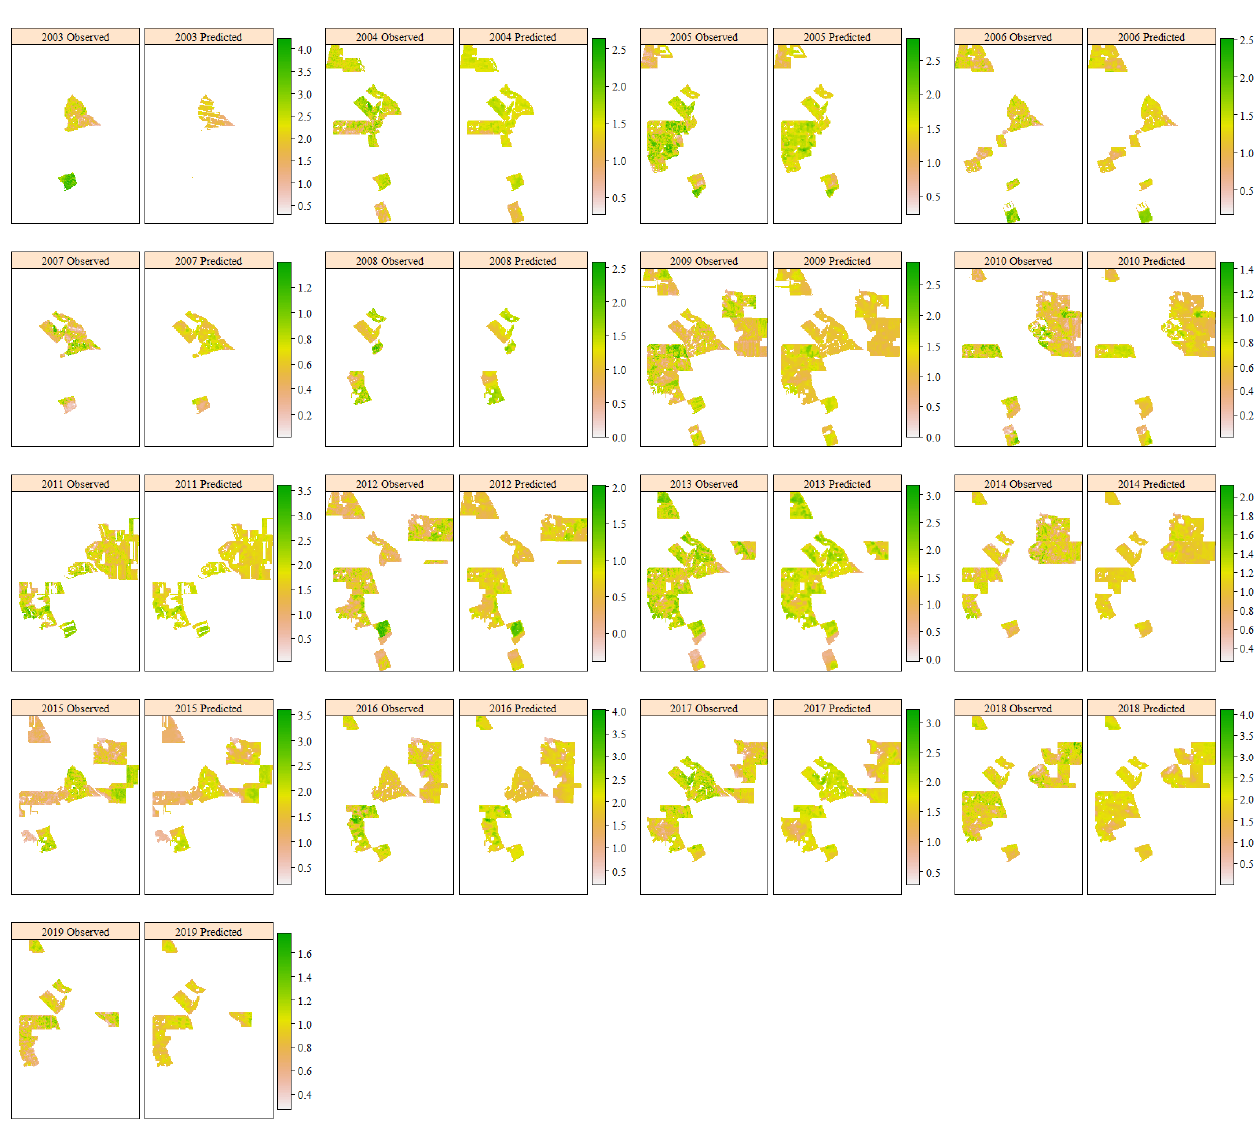
Figure 7. Hindcasts of wheat yield: Maps of observed and predicted wheat yield (t ha − 1 ) for 2004 to 2019.